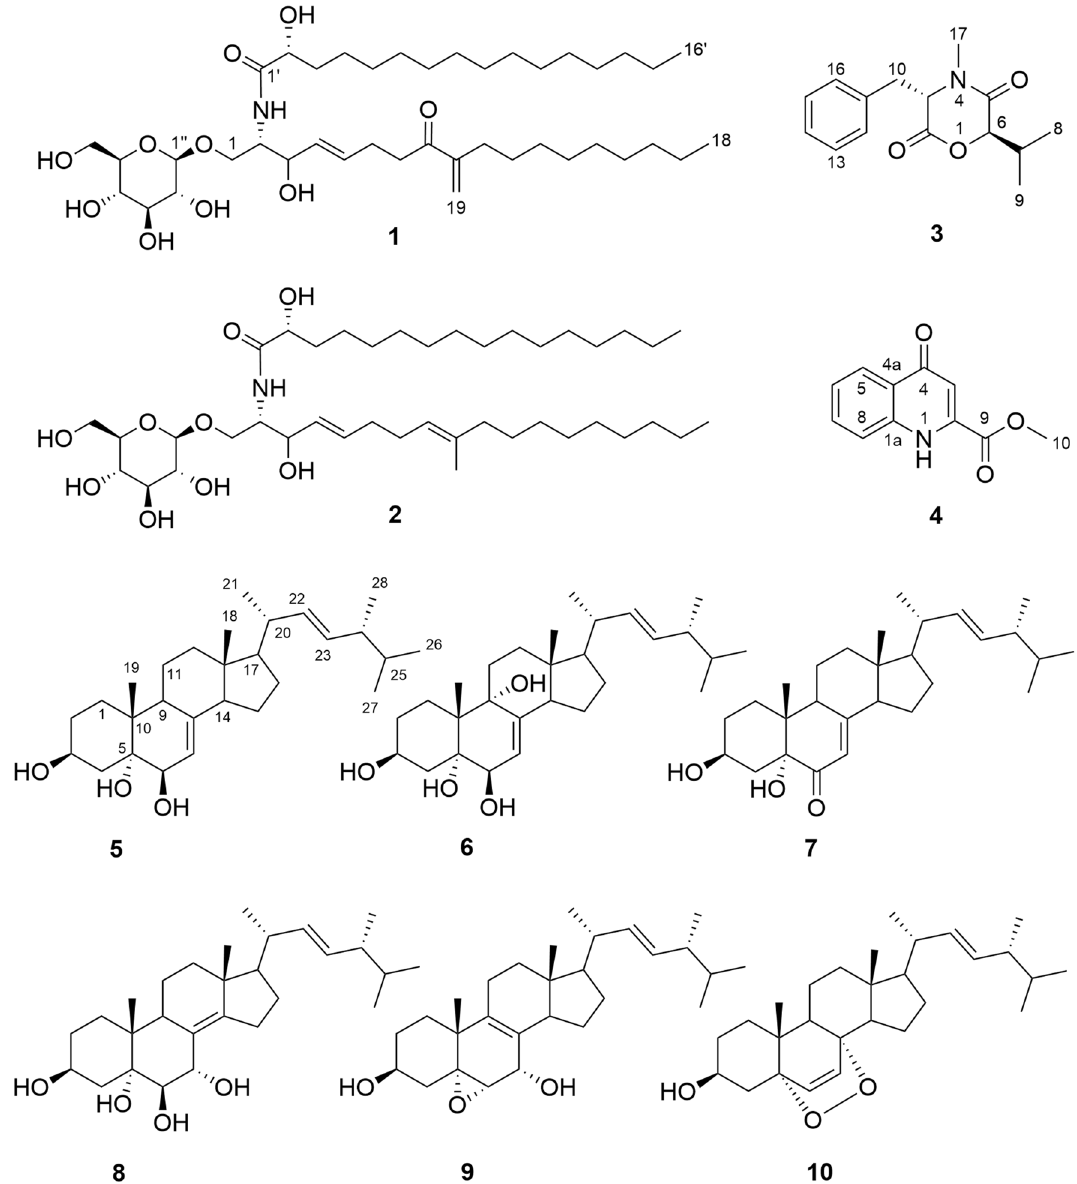
Figure 1. The chemical structures of the compounds 1 –